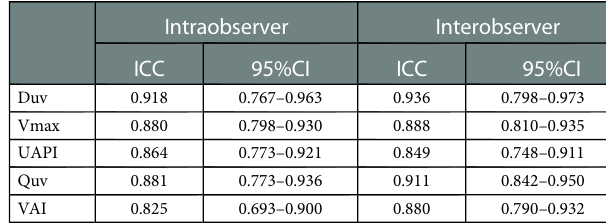
TABLE 3 Interclass correlation coef fi cients for Doppler